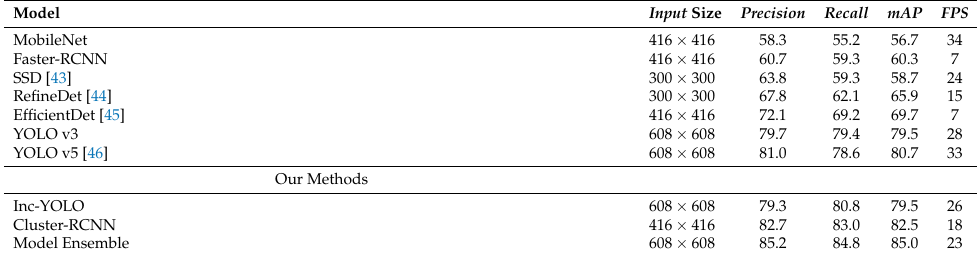
Table 1. Comparisons of different detection networks’ performance (in